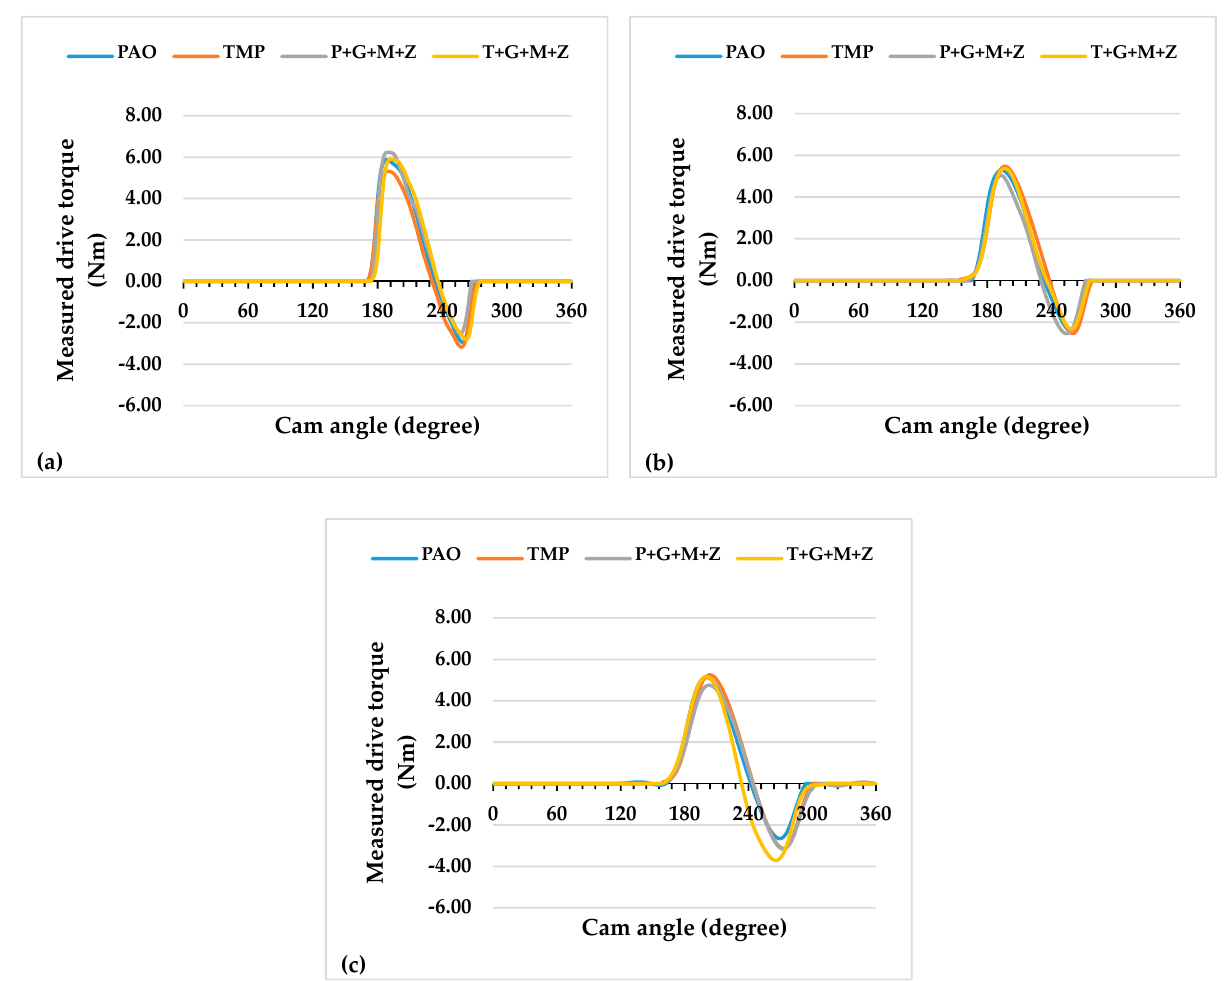
Figure 4. Instantaneous exhaust camshaft drive torque with a-C:H-coated tappets and a-C:H-coated camlobes at a lubricant temperature of 90 °C and camshaft speeds of ( a ) 400 RPM, ( b ) 800 RPM, and ( c ) 1200 RPM.